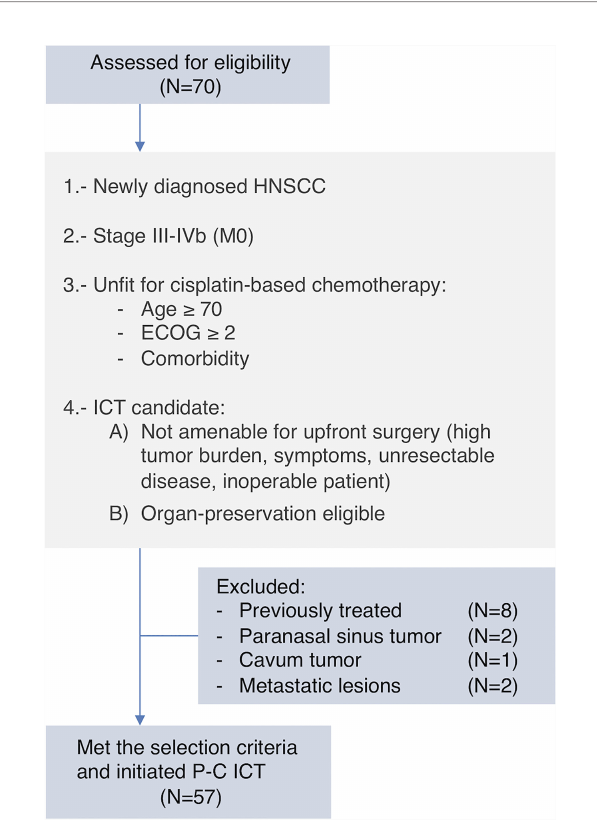
FIGURE 1 | Flowchart of patient selection and inclusion